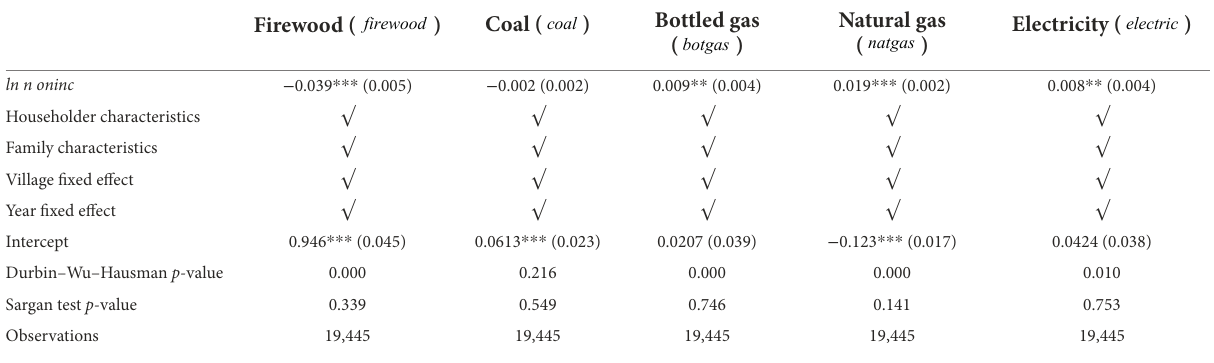
TABLE 6 Robustness tests: estimated by per capita non-farming income.